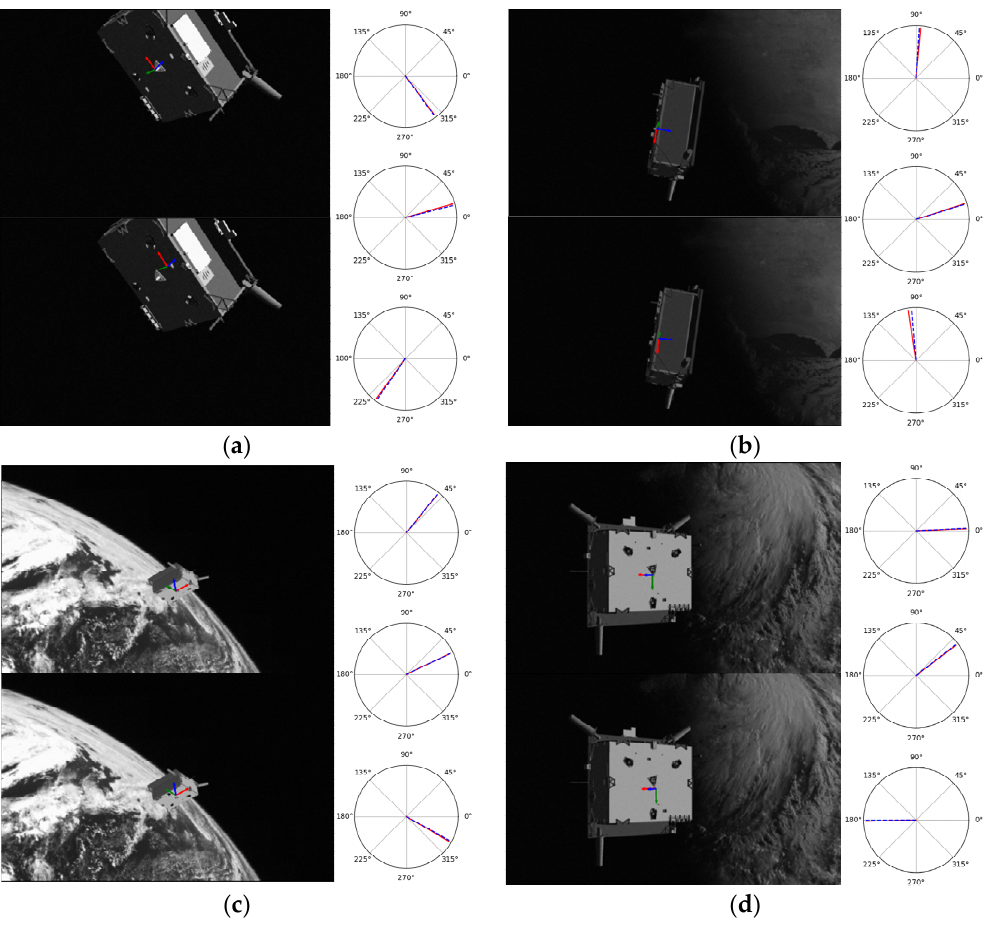
Figure 17. Pose estimation results of non-cooperative spacecraft. ( a ) Deep space background strong lighting. ( b ) Complex background dark lighting. ( c ) Earth background strong lighting. ( d ) Complex background strong